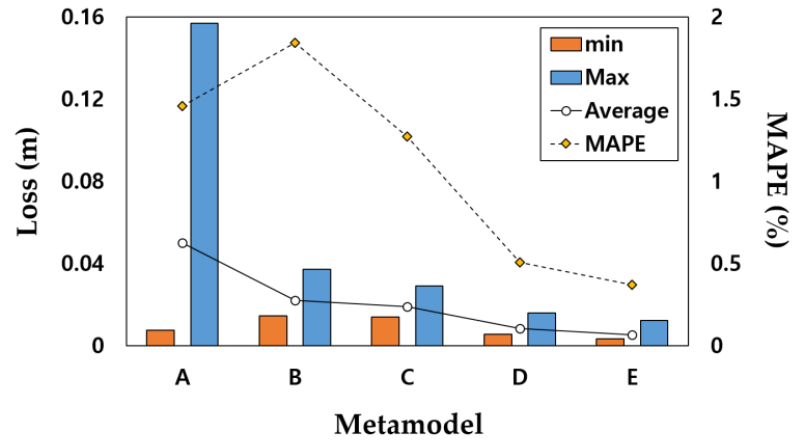
Figure 4. Results of loss and MAPE of each metamodel.